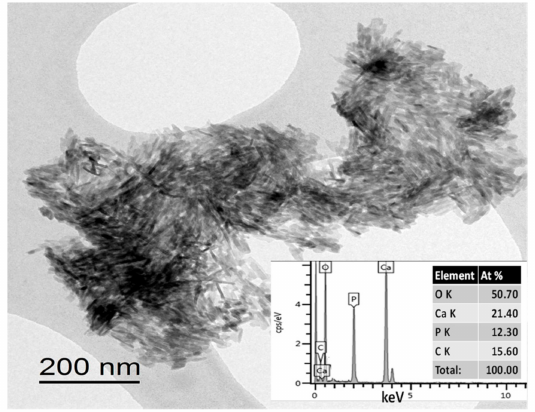
Figure 3. TEM image and EDX elemental analysis of the S4